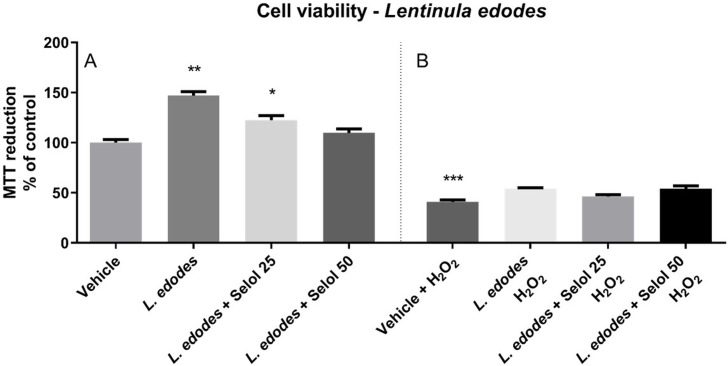
The effect of L. edodes extract with or without selenitetriglyceride supplementation on (A) the basal and (B) H2O2-induced 3-(4,5-dimethylthiazol-2-yl)-2,5-diphenyltetrazolium bromide (MTT) reduction in SH-SY5Y human neuroblastoma cell line. Results are shown as the percentage of control cells not exposed to the extract of L. edodes and H2O2. The results are expressed as mean ± standard error of mean. The significance of differences between the means was evaluated using the Bonferroni post-hoc test followed by a one-way analysis of variance (selenitetriglicerides 25 –addition of 25 mg of Se(IV)/L of medium; selenitetriglicerides 50 –addition of 50 mg of Se(IV)/L of medium); *P<0.05; **P<0.01; ***P<0.001 versus control cells exposed to vehicle (1:10 ethanol/H2O); n = 12).